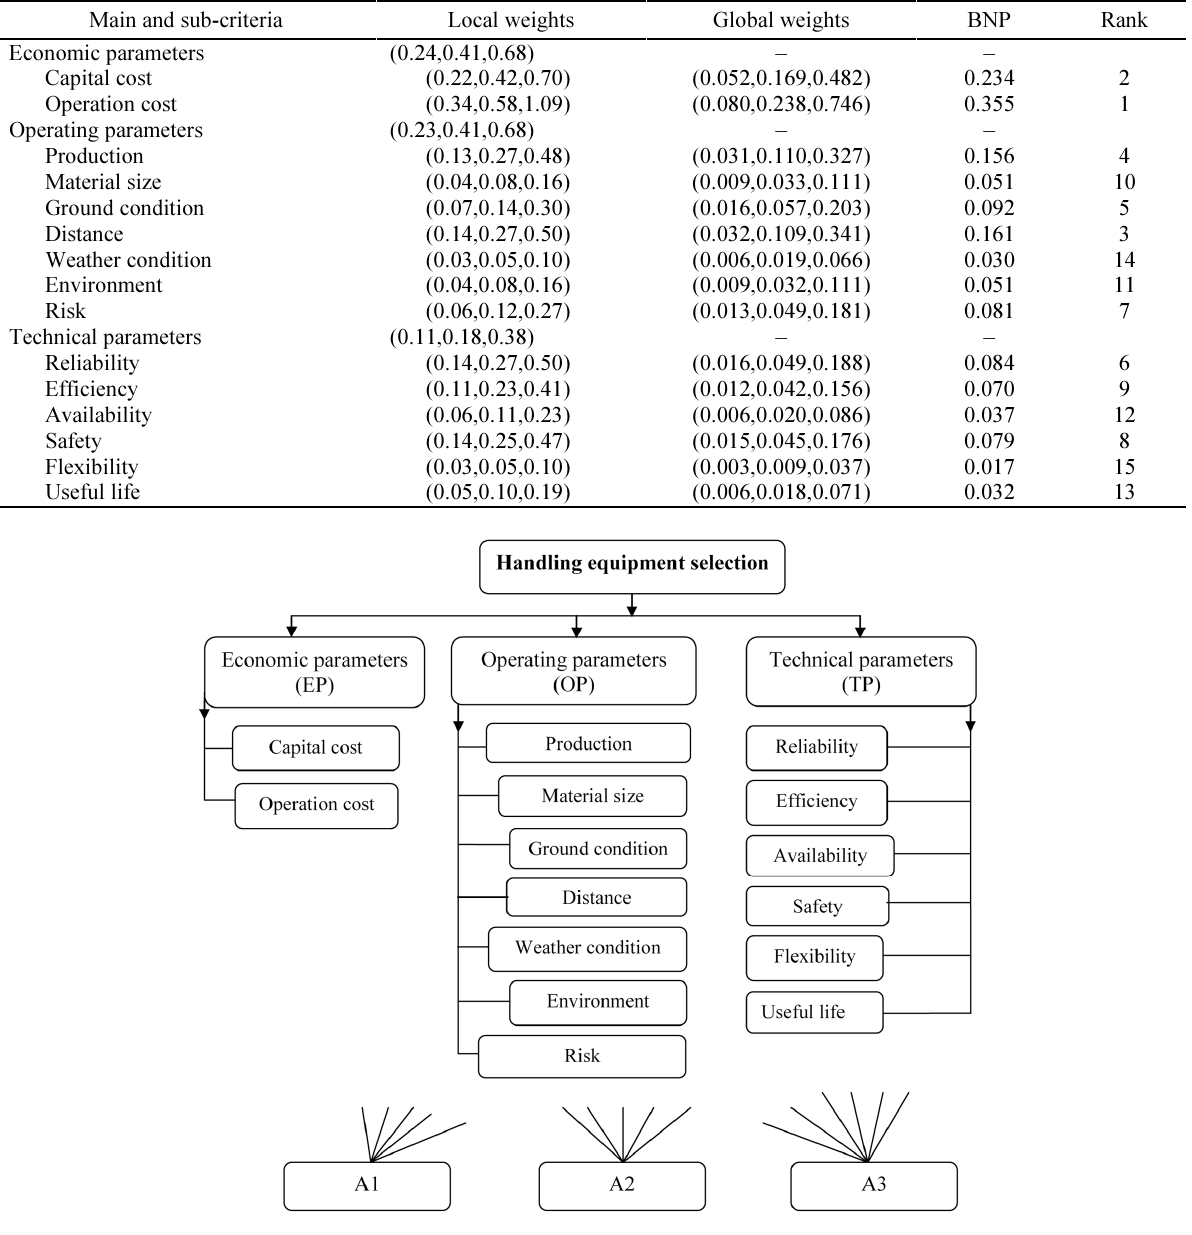
Fig. 5. Decision hierarchy